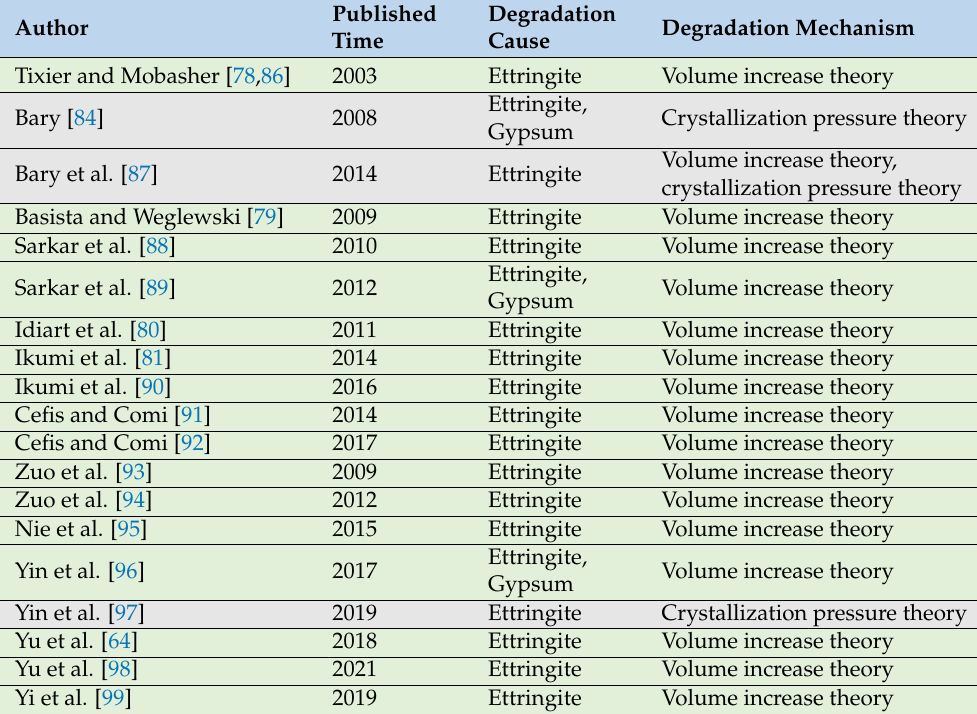
Table 5. Chemo-mechanical models for concrete subjected to